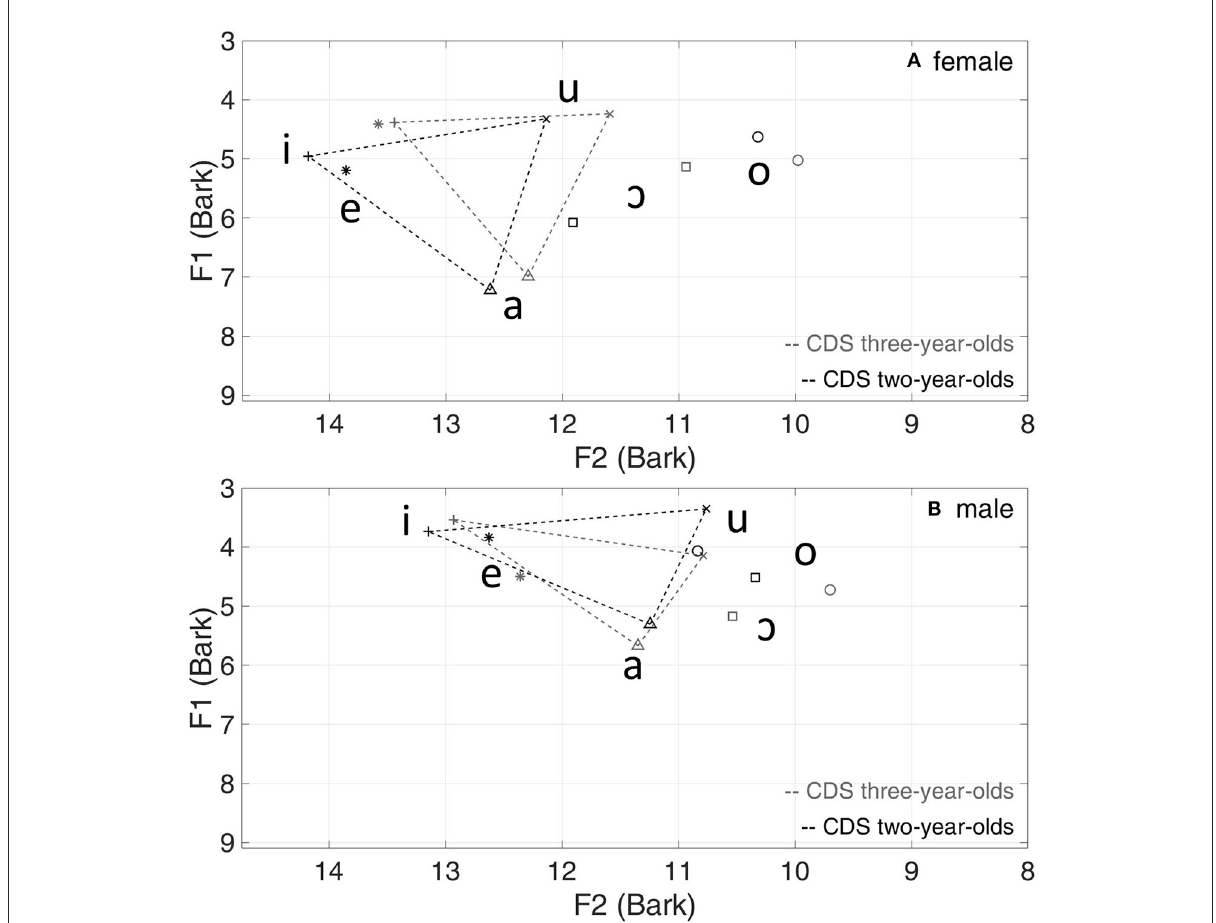
FIGURE1 Mean vowel formants (Bark) and triangles of the 2-year-olds vs. 3-year-olds in CDS for women (A) and men (B)